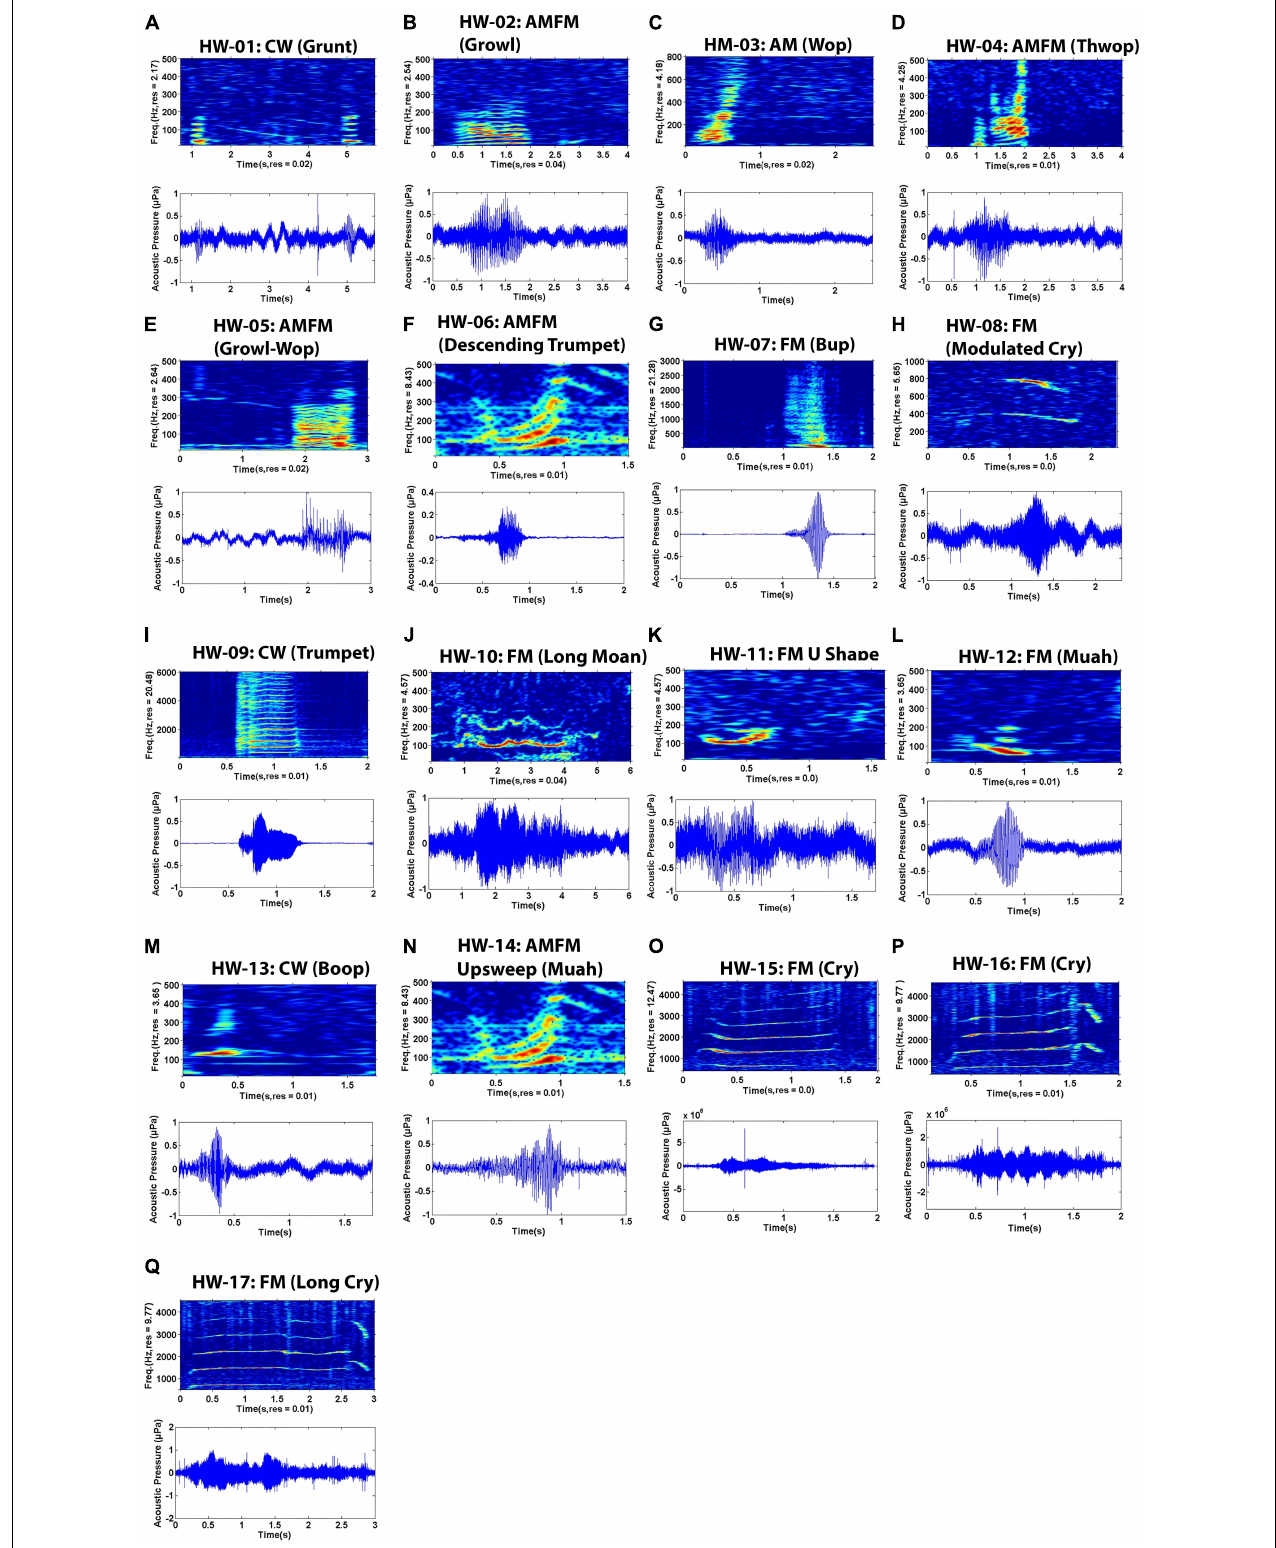
FIGURE 2 | Spectrograms (top) and waveform (bottom) pairs (A–Q) of unique non-song sounds recorded off Geographe Bay and Port Hedland, northwestern Australia. Sound names are organized by number (e.g. HW-01), spectral feature (e.g. FM) and onomatopoeic name in parenthesis (e.g. Growl). FM = Frequency modulated, AM = Amplitude modulated, AMFM = Frequency and amplitude modulated, CW = Constant wave.